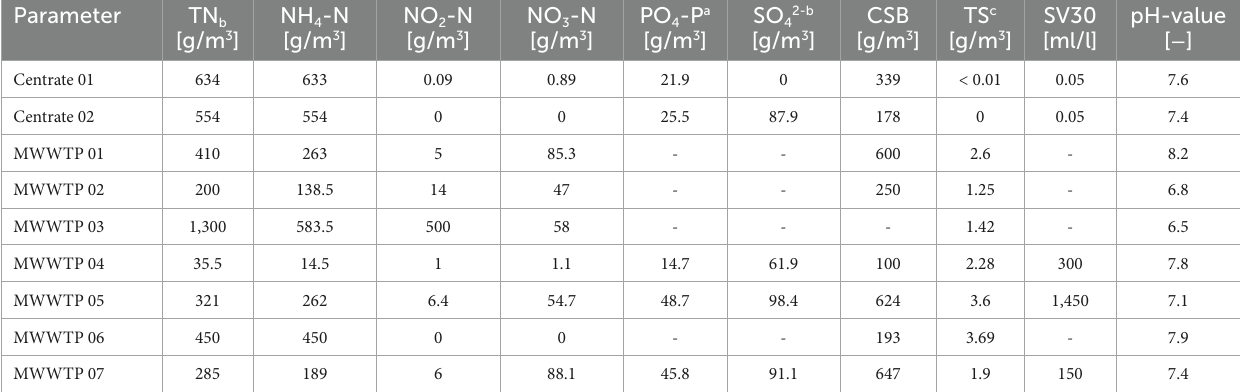
TABLE 1 The original composition of the tested side stream deammonifying sludges as mainstream inoculum and centrate from various MWWTPs.